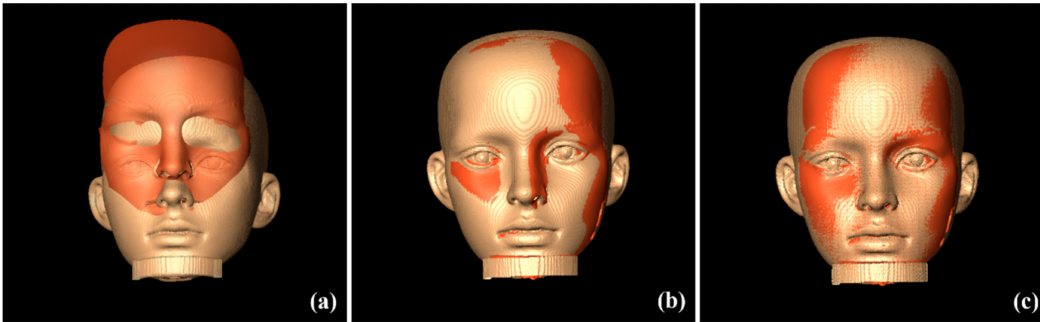
Figure 4. The phantom shown before rotation of the 3D CT model (in yellow) into the 3D calibrated scanned model (in red) ( a ), after rotation by coarse registration between the two models using a principal component analysis (PCA) ( b ), and after rotation by fine registration using CPD ( c